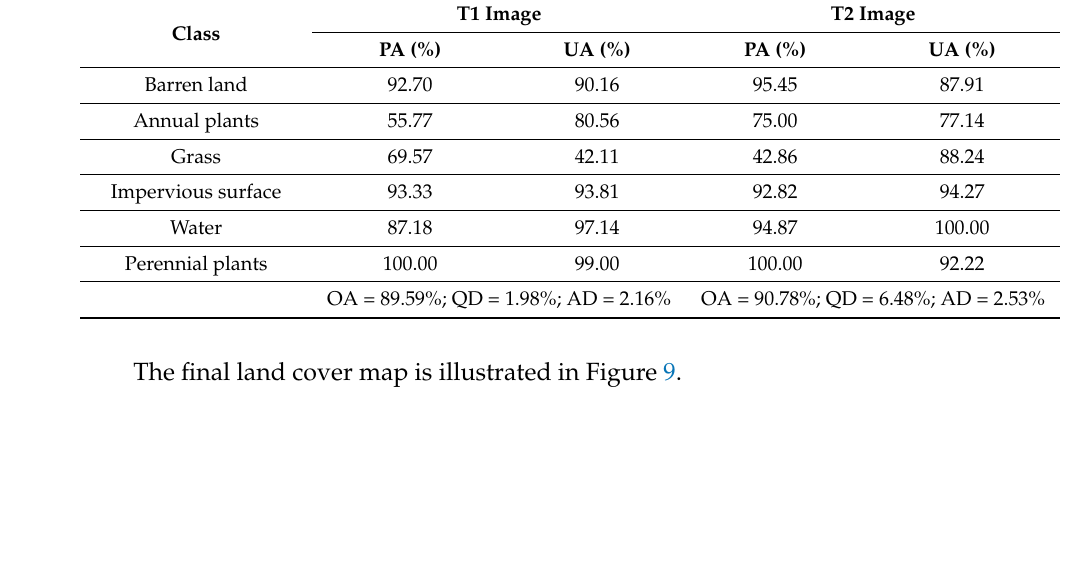
Table 4. The accuracy of land cover maps produced from the single-date images.